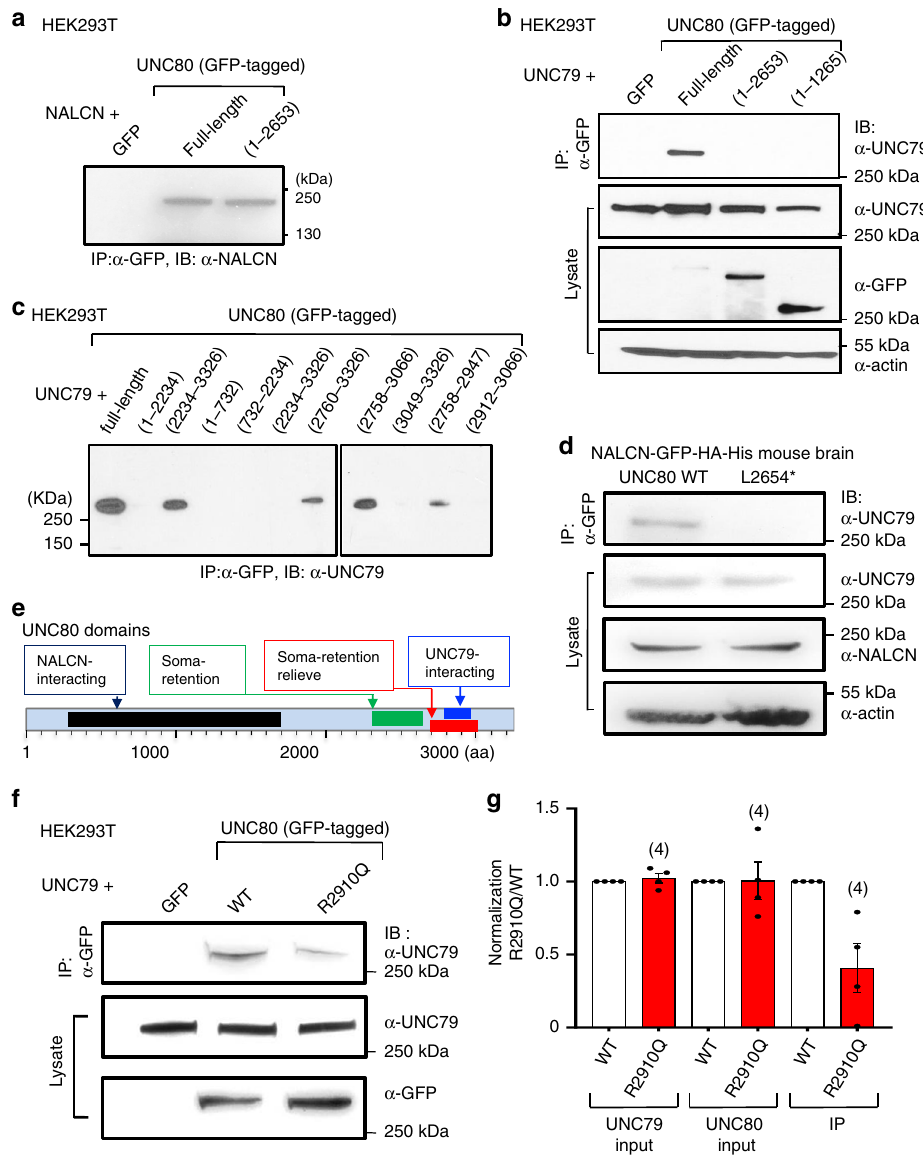
Fig. 8 UNC80 ’ s C-terminus contains an UNC79-interacting domain. a Association between UNC80 mutant truncated at L2654 (containing residues 1 – 2653) and NALCN. Cell lysates from HEK293T cells co-transfected with NALCN and GFP (as control), GFP-tagged full-length UNC80 or the truncation mutant were immunoprecipitated (IP) with anti-GFP and blotted with anti-NALCN. b Lack of association between UNC80 mutant truncated at L2654 and UNC79. Cell lysates from HEK293T cells co-transfected with UNC79 and GFP (as control), GFP-tagged full-length UNC80, or truncated UNC80 containing only residues 1 – 2653 or 1 – 1266 were immunoprecipitated (IP) with anti-GFP and blotted with anti-UNC79 (upper). Lower 3 panels: whole lysates were blotted with anti-UNC79, anti-GFP or anti-actin (for loading control). c Mapping UNC80 ’ s UNC79-interacting domain. Cell lysates from HEK293T cells co- transfected with UNC79 and GFP-tagged full-length UNC80, or truncated UNC80 containing residues as indicated were immunoprecipitated (IP) with anti-GFP and blotted with anti-UNC79. d Disruption of UNC79-NALCN association in mouse brains lacking the C-terminal part of UNC80. Brain proteins were prepared from the NALCN-GFP-HA mice and those that also carry the homozygous L2654* mutation in the NALCN-GFP-HA-His background. Upper panel: NALCN was pulled down with anti-GFP antibody and the complex was probed with anti-UNC79. Lower 3 panels: whole lysates were blotted with anti-UNC79, anti-NALCN or anti-actin (lower 3 panels). e Summary of UNC80 ’ s functional domains: NALCN-interacting domain (residues 301 – 1700), soma-retention domain (2387 – 2657), soma-retention relieve domain (2758-3000), and UNC79-interacting domain (2758 – 2947). f , g Reduced UNC80 – UNC79 interaction strength associated with intellectual disability. f UNC79 was co-transfected with GFP, GFP-tagged wild-type UNC80 or GFP- tagged R2910Q UNC80 mutant in HEK293T cells. Immunoprecipitates (IP with anti-GFP, upper panel) and whole-cell lysates (lower two panels) were blotted (IB) with anti-UNC79 or anti-GFP as indicated. In the lower panel, GFP alone in the control lane migrated at ~20 kDa (outside the molecular range shown) and is not visible in the blot. g Protein levels normalized to that obtained with WT UNC80. Results were from four independent experiments. In ( a – d , f ), three or more independent repeats were performed with similar results. Data are presented as mean values± SEM. Numbers of repeats are in parentheses. Source data are provided as a Source Data fi